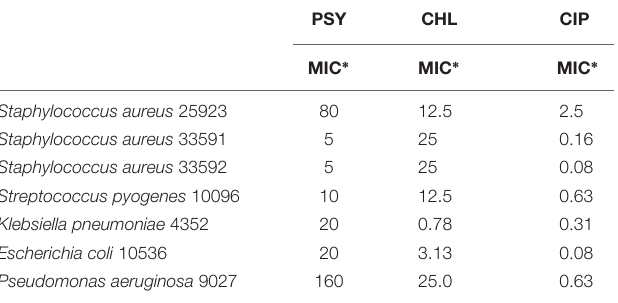
TABLE 1 | Antibacterial activity of the psychorubrin.